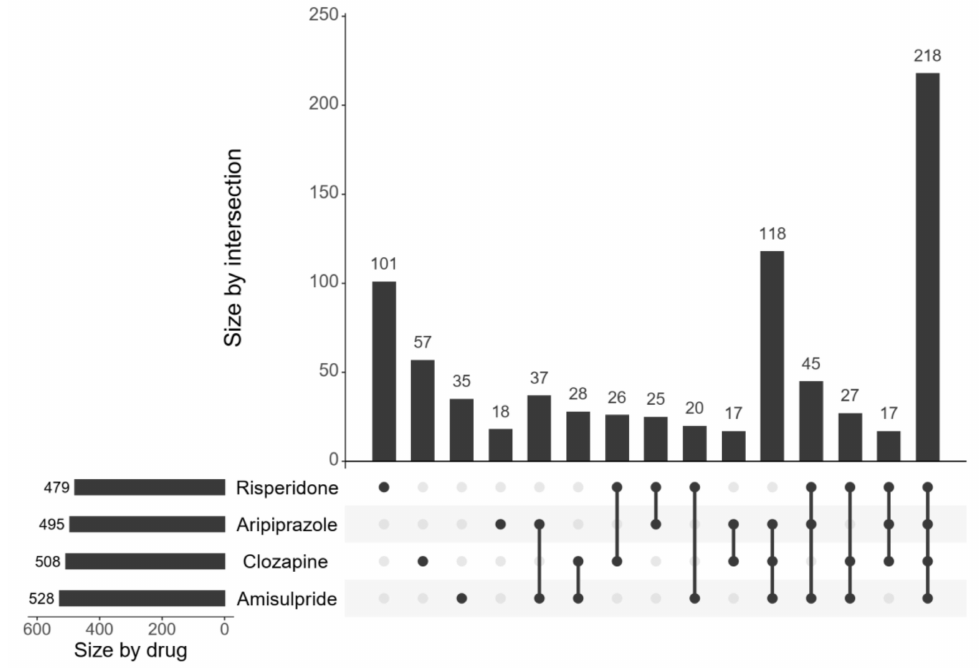
Figure 2. The number of genes whose expression levels were reversed by the individual and com- bination of antipsychotic drugs relative to the differential expression in post-mortem brains. The total number of genes with reverse regulated expression by each drug is shown on the leftmost horizontal axis. The vertical axis from the top panel demonstrates the unique sets of genes reversed by individual drugs or the intersection of these sets, indicated by the connected lines and dots along the horizontal